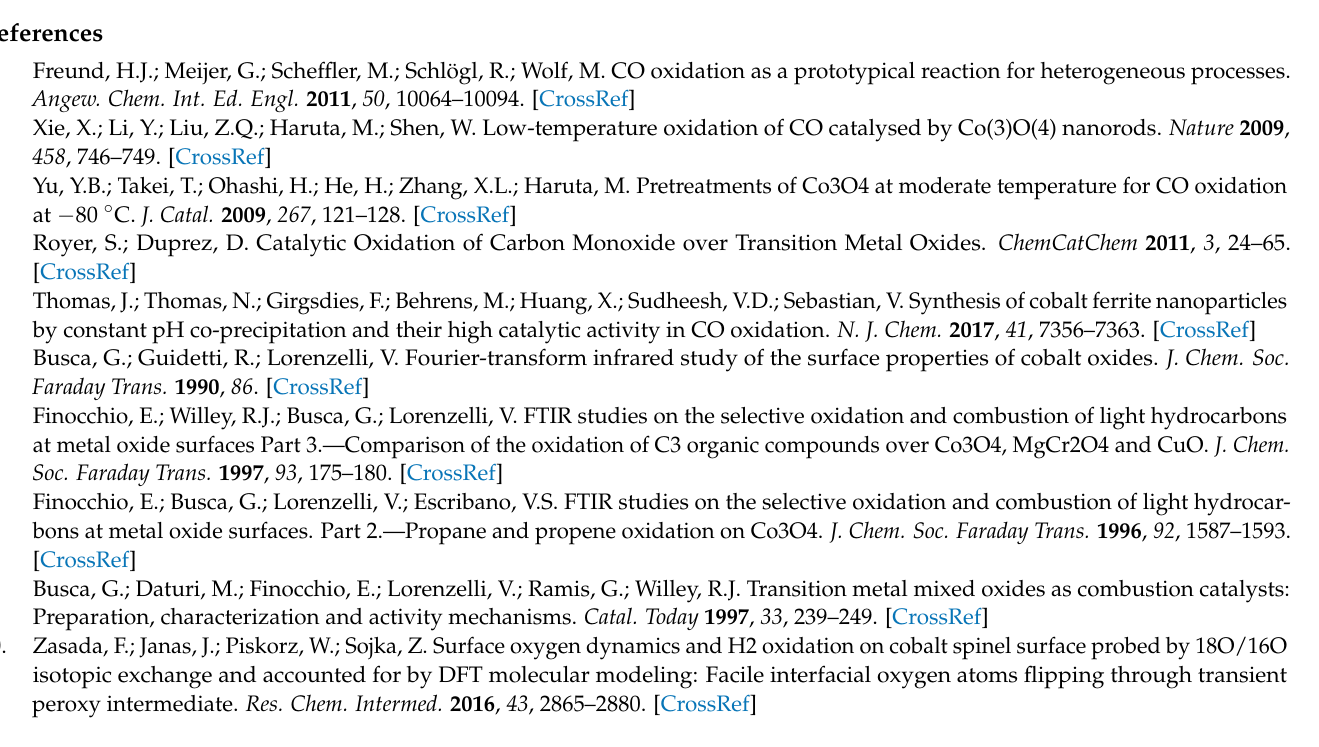
templated Co:Fe 7:1. Figure S10: CO oxidation activity in the different runs for SBA-15 templated Co:Fe 3:1. Figure S11: CO oxidation activity in the different runs for SBA-15 templated CoFe 2 O 4 . Figure S12: CO oxidation activity in the different runs for Co 3 O 4 C600. Figure S13: CO oxidation activity in the different runs for Co 3 O 4 P800. Figure S14: Differences in conversion at 75 ◦ C between the 2nd and the 3rd run of CO oxidation. Figure S15: Conversion at 75 ◦ C in the 2nd run compared to the activation between 2nd and 3rd run for the SBA-15 templated materials. Figure S16: CO temperature programmed reduction of C600 without TPO and after TPO showing the evolved CO 2 concentration ( a ) and the temperature in the reactor ( b ). Figure S17: ( a ) Initial measurement of 3:1 in the cyclic CO oxidation in 2% CO and 20% O 2 in comparison to a new measurement in 2% CO and 1% O 2 performed on another setup. Figure S18: ( a ) SEM image of C600 before catalysis. ( b ) SEM image of C600 after catalysis. ( c ) SEM image of C800 before catalysis. ( d ) TEM image of C800 after catalysis. ( e ) SEM image of S500 before catalysis. ( f ) TEM image of S500 after catalysis. Figure S19: XRD patterns of the spent